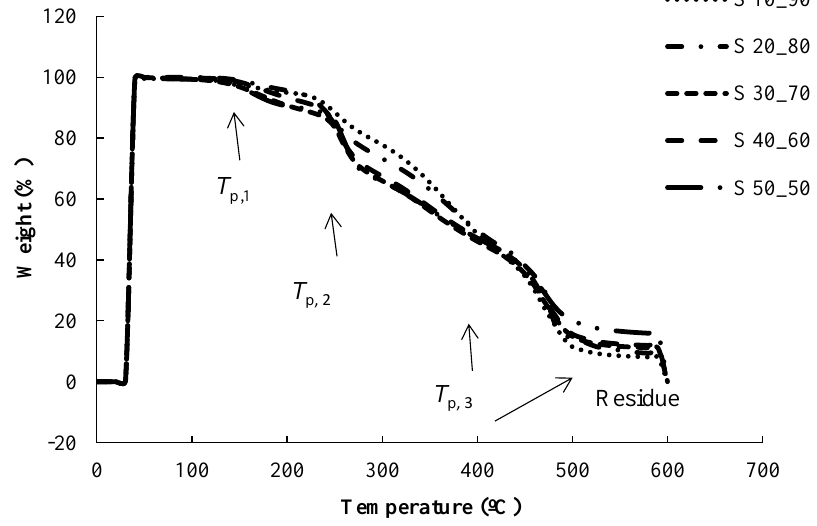
Figure 5. TGA thermograms of the PVA/PMVE-MA interpolymer membranes.